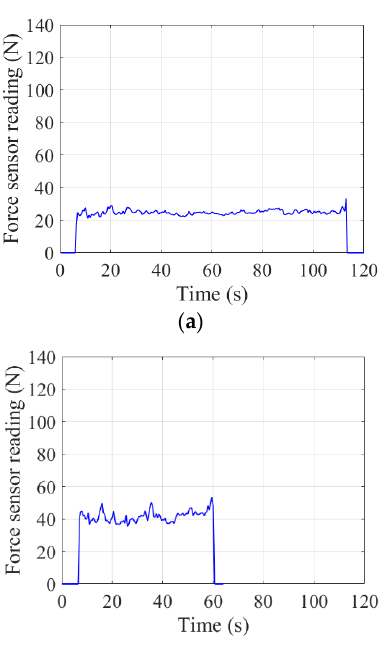
Figure 17. The force sensor readings of the smart tool holder at the working condition of constant feed rate ( f ) and cutting depth ( ap ): ( a ) f = 0.1 mm/rev, ap = 0.1 mm; ( b ) f = 0.1 mm/rev, ap = 0.3; ( c ) f = 0.2 mm/rev, a p = 0.1 mm; and ( d ) f = 0.2 mm/rev, a p = 0.3 mm. The spindle rotates at 500 rpm and the cut length is 90 mm.